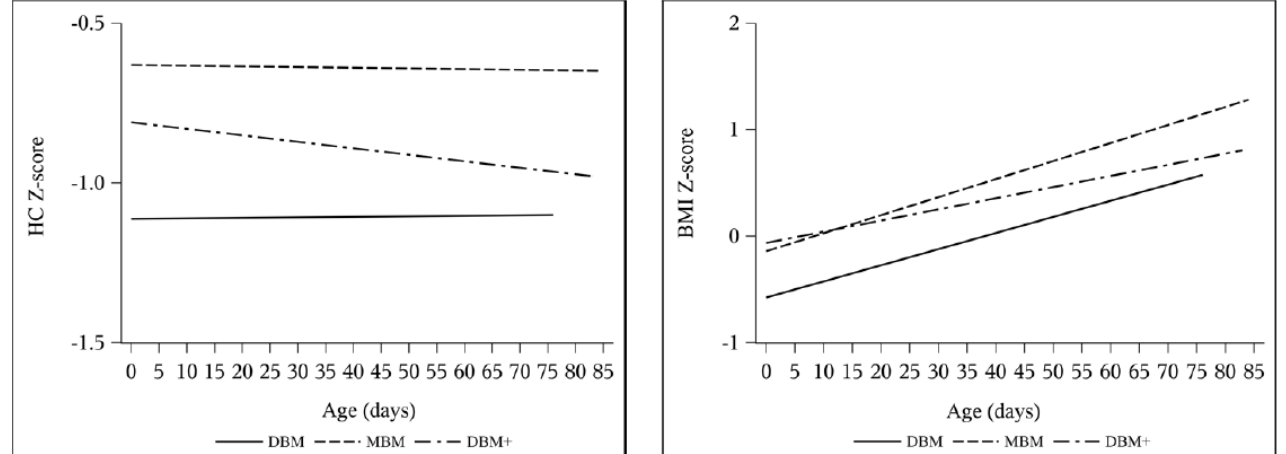
Figure 3. Unadjusted longitudinal models of z-score change over time for Fenton weight, length, and HC and Olsen BMI by cohort: DBM ( n = 58), MBM ( n = 64), DBM+ ( n = 59).